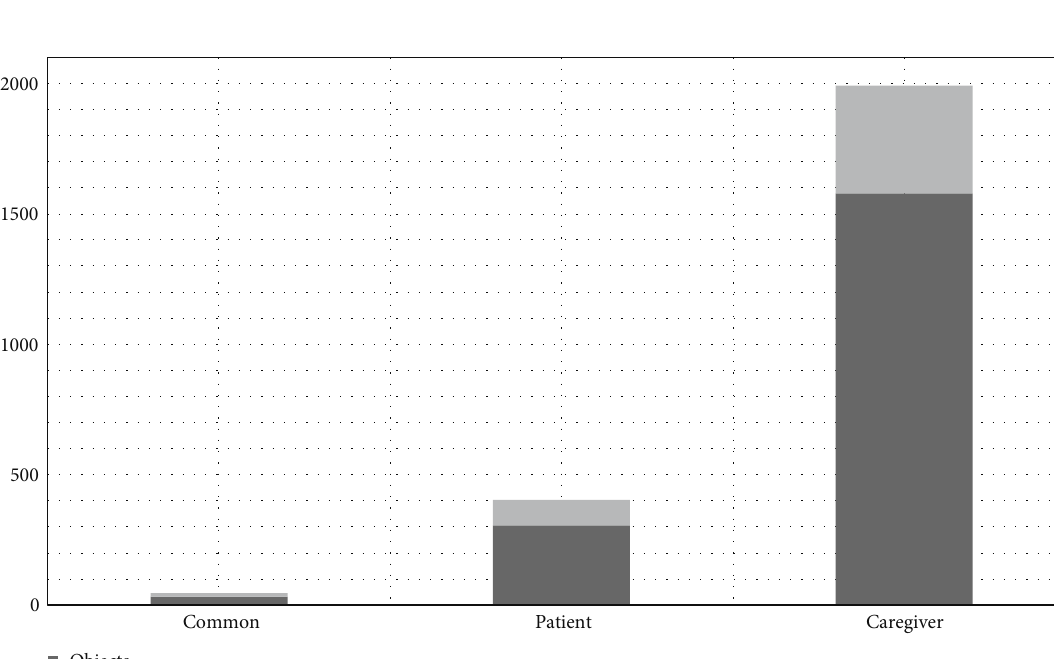
Figure 7: Weinschenk and Barker ’ s interface evaluation.